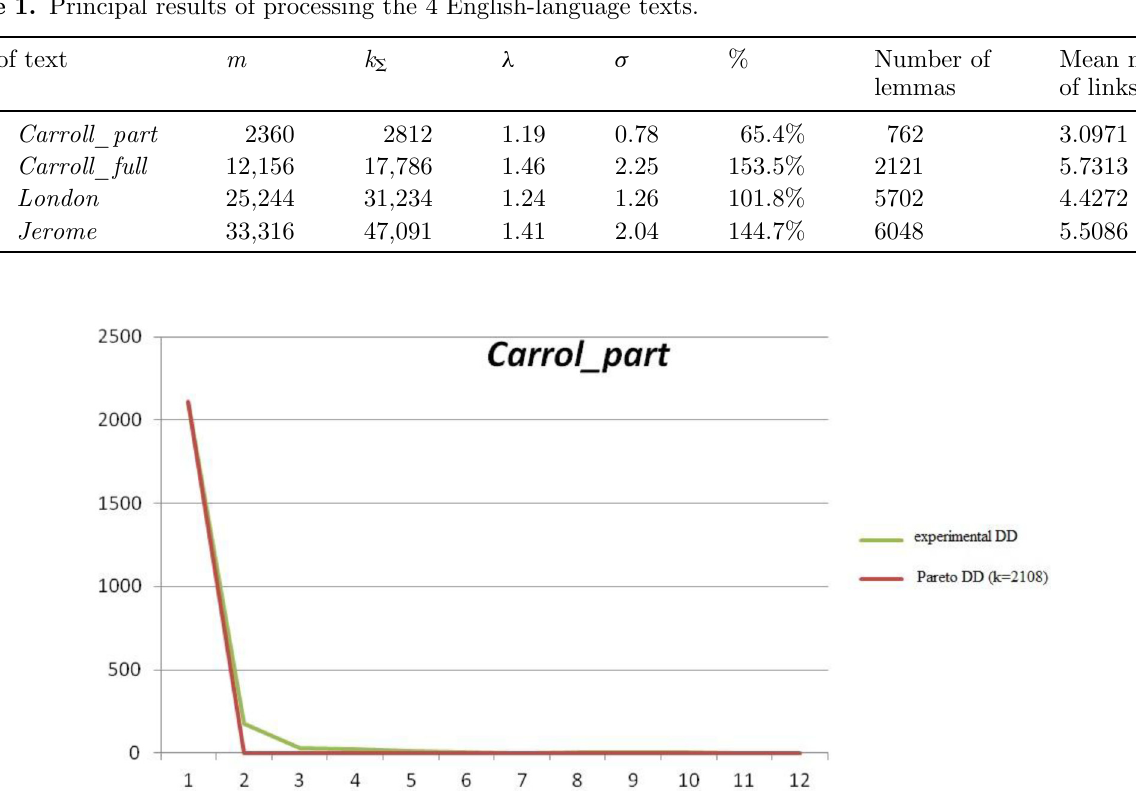
Fig. 3. Analysis of the experimental distribution density (DD) law for text